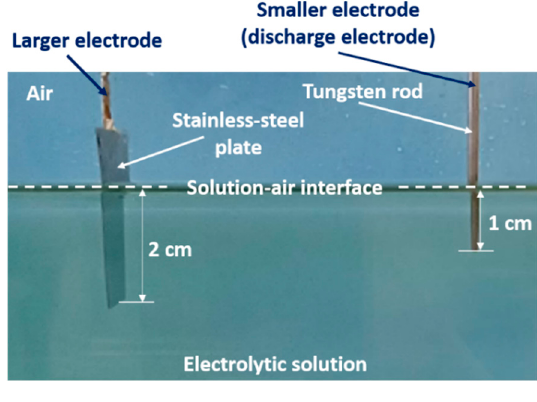
Formation of the plasma discharge at the cathode.